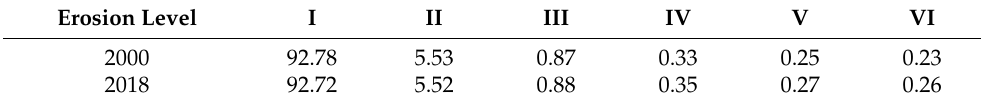
Table 4. The percentage of soil erosion level in the Heihe River Basin from 2000 to 2018. (unit: %).